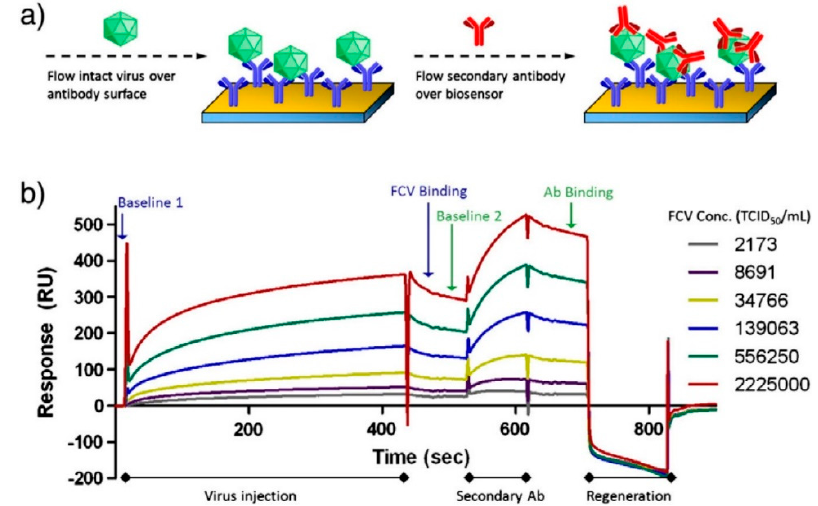
Figure 2. Detection of feline calicivirus (FCV) via a surface plasmon resonance (SPR) assay. ( a ) The diagram of the detection assay. ( b ) The sensorgram (reference flow cell subtracted) for FCV (with different concentrations) and secondary antibody (Ab). A greater response (RU) achieved when FCV and secondary Ab binds (reprinted from Yakes et al. [136] with permission from the publisher).